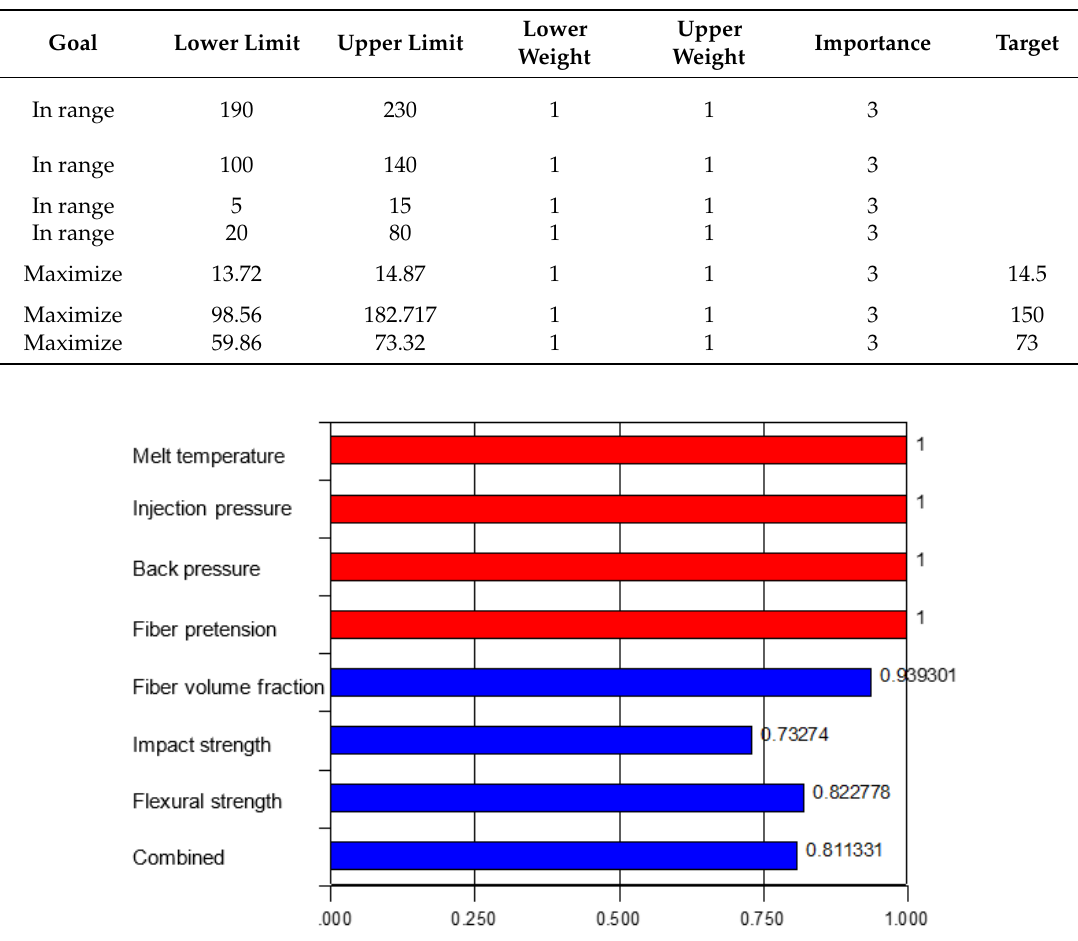
Table 9. Determination of desirability functions.